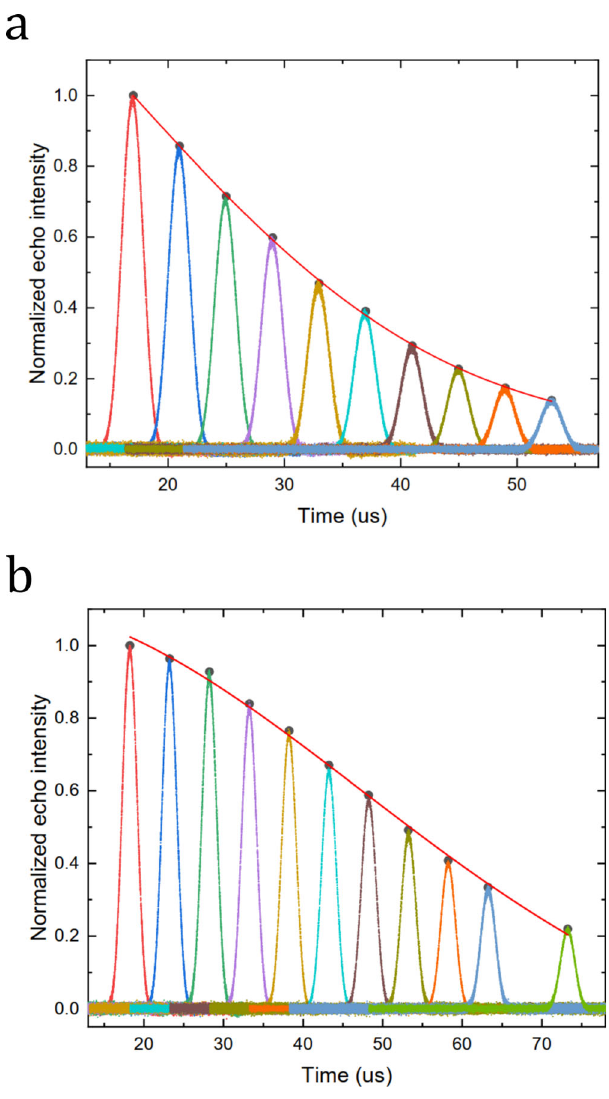
Fig. 3 Ef fi ciency decay in the NLPE memory. Each data point represents the area of the readout echo over a 4- μ s window. The echo traces are included for reference. a The decay of the echo intensity for varying delay τ = 2( t − t 3 3 2 ). b The decay of the echo intensity for varying delay τ = t − t 2 4 1 . The red lines are Gaussian